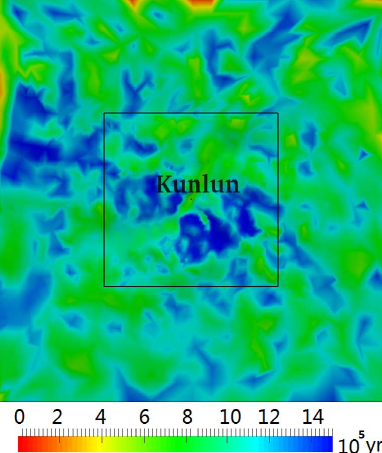
Figure 6. Age of the ice at 95% depth in the 70 × 70km 2 domain (central 30 × 30km 2 region is boxed) using girdle fabric with 1 / 3 transition depth, 60mWm − 2 heat flux and surface temperature of − 58.5 ◦ C. The parts with no basal melt are limited to an age of